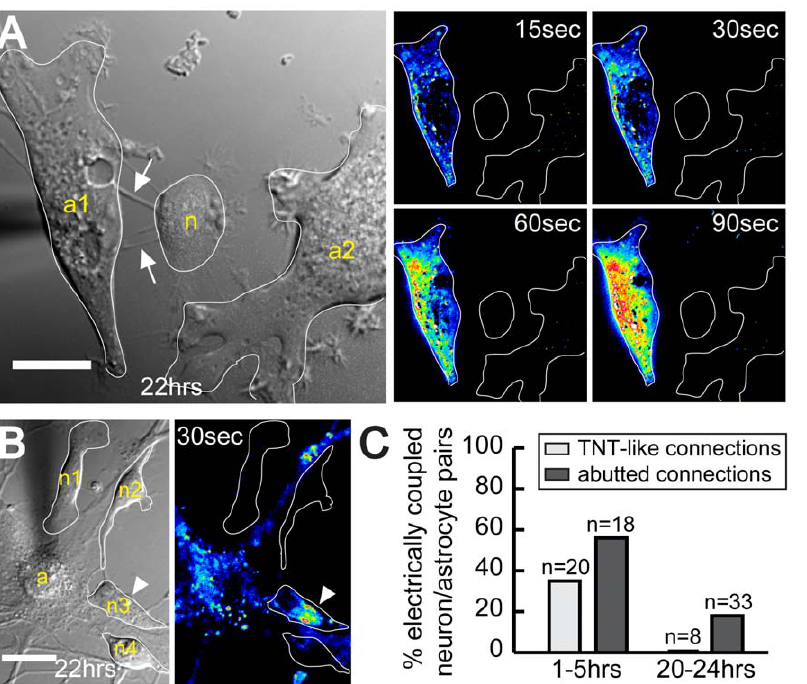
Figure 3. TNT-dependent electrical coupling between astrocytes and neurons declines during prolonged co-culturing. ( A ) A TNT- connected astrocyte-neuron cell pair did not show electrical coupling after 24 hours of co-culture. The DIC image depicts TNT-like structures ( arrows ) formed between neuron (‘‘n’’) and astrocyte (‘‘a’’) after 22 hours of co-culture. The neuron did not display depolarization when the astrocyte was stimulated (pseudo-colored fluorescence image, right ). ( B ) Abutted neuron/astrocyte show less electrical coupling after 24 hours of co-culturing. The DIC image shows an astrocyte (‘‘a’’) closely associated with 4 neurons (‘‘n1’’, ‘‘n2’’, ‘‘n3’’ and ‘‘n4’’). Only one neuron (‘‘n3’’, arrowhead ) was electrically coupled with the astrocyte as indicated by the increase of DiBAC 4 (3) fluorescence after 30 sec (pseudo-colored fluorescence image, right ). ( C ) Electrical coupling ratio between neurons and astrocytes of abutted and TNT-connected cell pairs. Mechanical stimulation experiments were performed 1–5 or 20–24 hours after start of the co-culture. The percentage of electrically coupled neuron-astrocyte cell pairs (abutted or TNT- connected) was determined. ‘‘n’’, number of cell pairs analyzed from at least three independent experiments. Scale bars=20 m m.